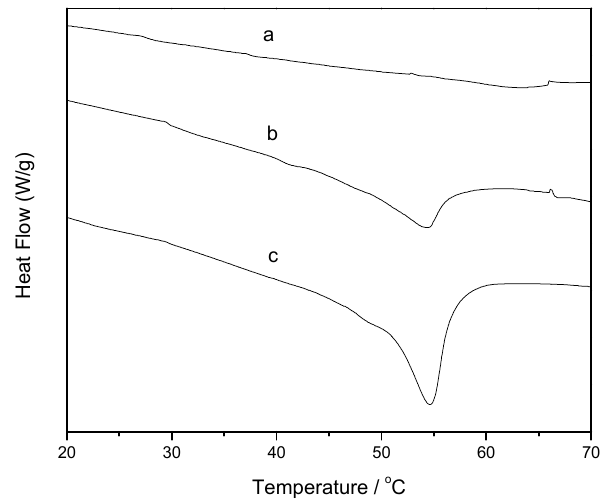
Figure 7. DSC thermographs of control nanoliposomes (no BTH) (a); LIP1 (10% BTH) (b); and LIP2 (20% BTH) (c).